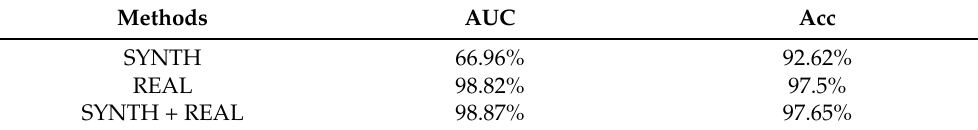
Table 5. Segmentation performance, using the single-step method, on the CHASE_DB1 dataset.